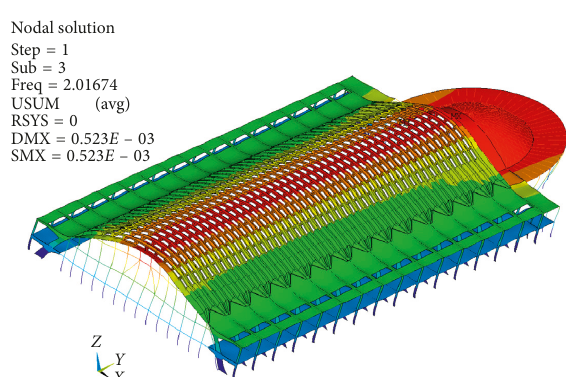
Figure 12: Mode 3 of Hall B in its damaged configuration (front view).